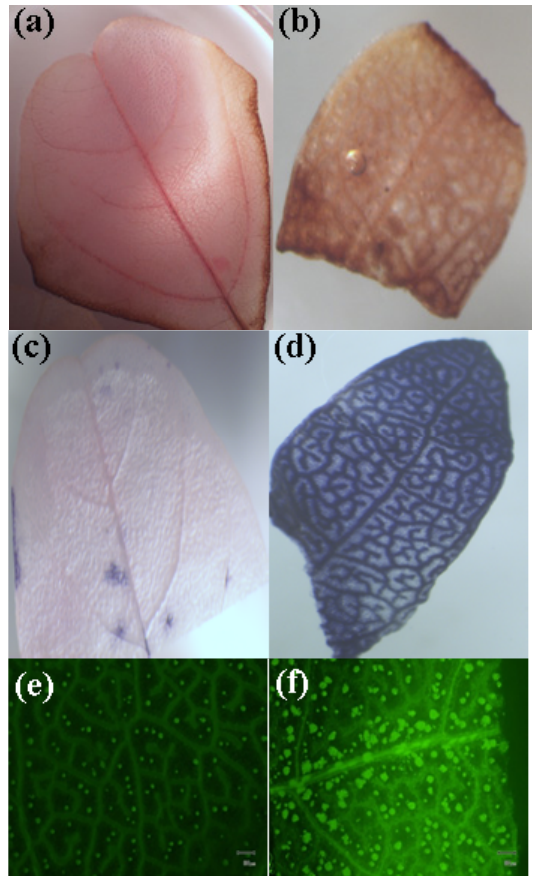
Figure 5. Detection of ROS in red spinach leaves. 15 day-old fresh leaves treated with or without MWNTs (0 and 1000 mg/L) were used for all measurements. ( a , b ) Staining using the 3–3'-diaminobenzidine (DAB) (Image obtained with a magnification of 4×). The brown staining indicates the formation of a brown polymerization product when H DAB, and viewed with light microscopy. ( c , d ) Staining using the NBT (Image obtained with a magnification of 4×). The blue staining indicates the formation of a blue formazon product when superoxide reacts with NBT, and viewed with light microscopy. ( e , f ) Staining with DCFH-DA (Image obtained with a magnification of 4×). The green signal indicates the presence of hydroperoxides inside the cells. Leaves were observed with fluorescence